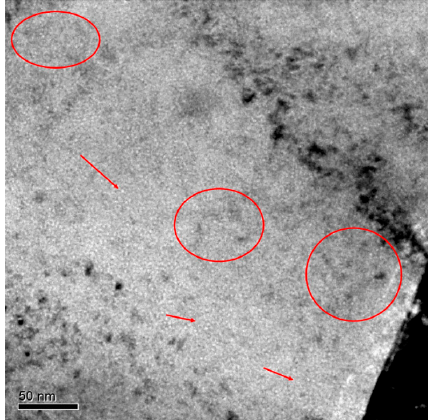
Figure 7. TEM micrograph of EUROFER97 steel annealed at 450 °C for 100 h showing the distribution of bubbles within the matrix in zone C at the lowest He concentration (518 to 445 appm He). Red arrows and ovals highlight some cavities.